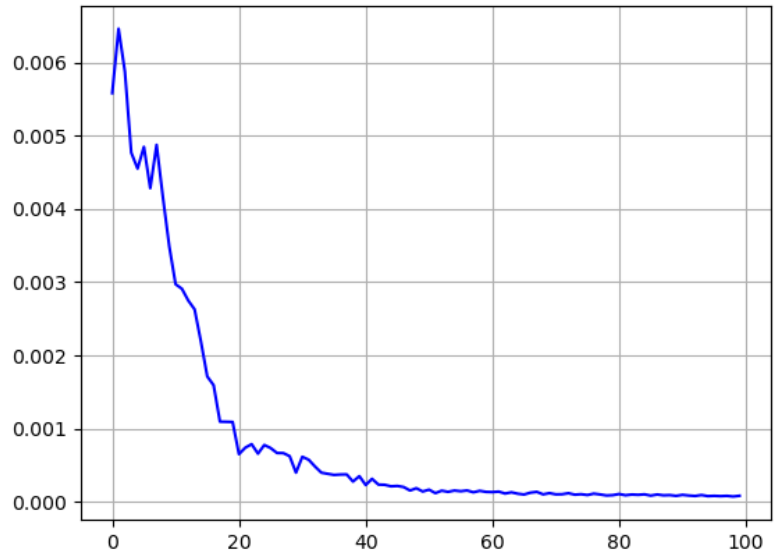
Figure A1. US500 Losses , 45